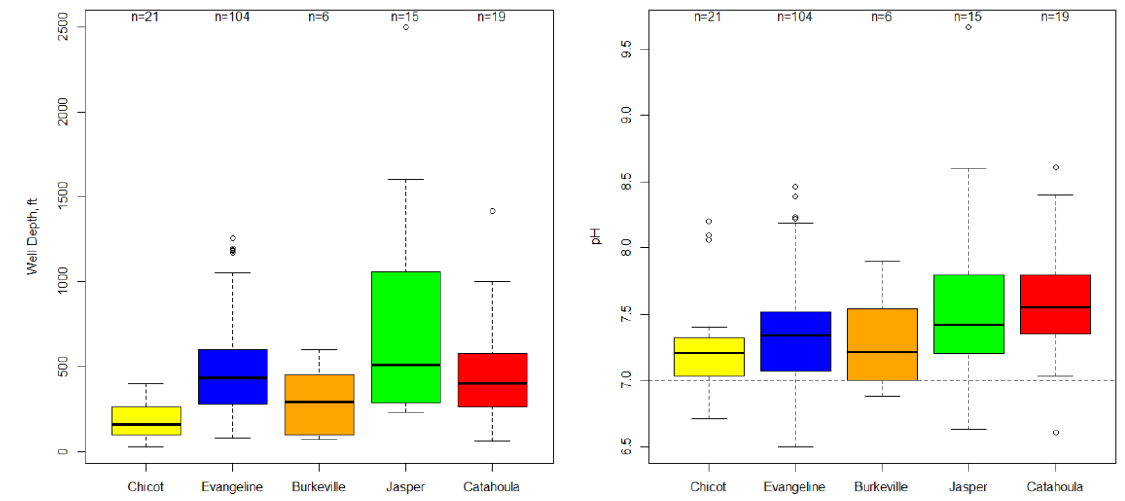
Figure 4. Distribution of pH and well depths by stratigraphic unit (dotted line shows neutral pH).